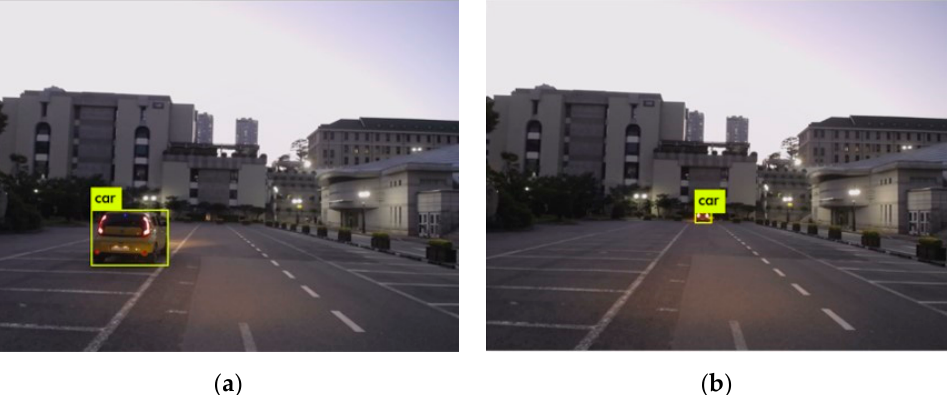
Figure 3. ( a ) The bounding box of the SV in the adjacent lane and close up; ( b ) the bounding box of the SV in the same lane and far